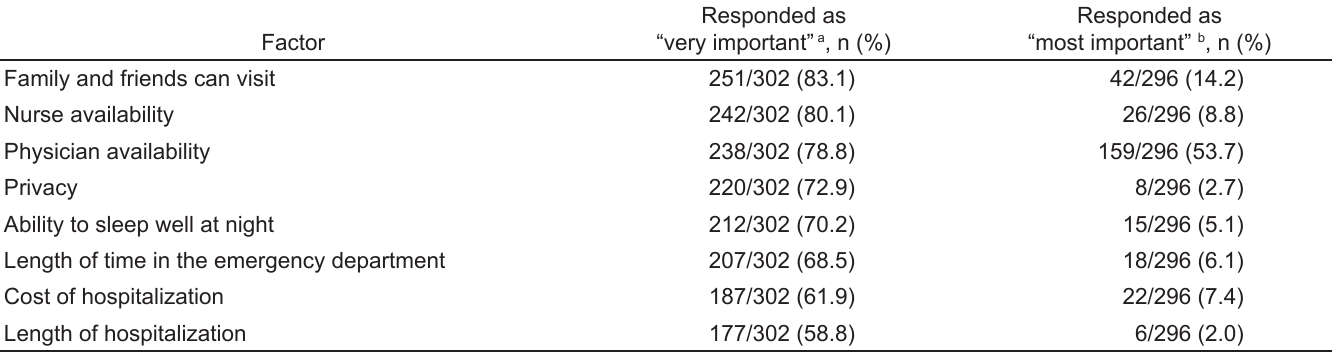
Table 2. Importance of hospitalization factors, n=302.